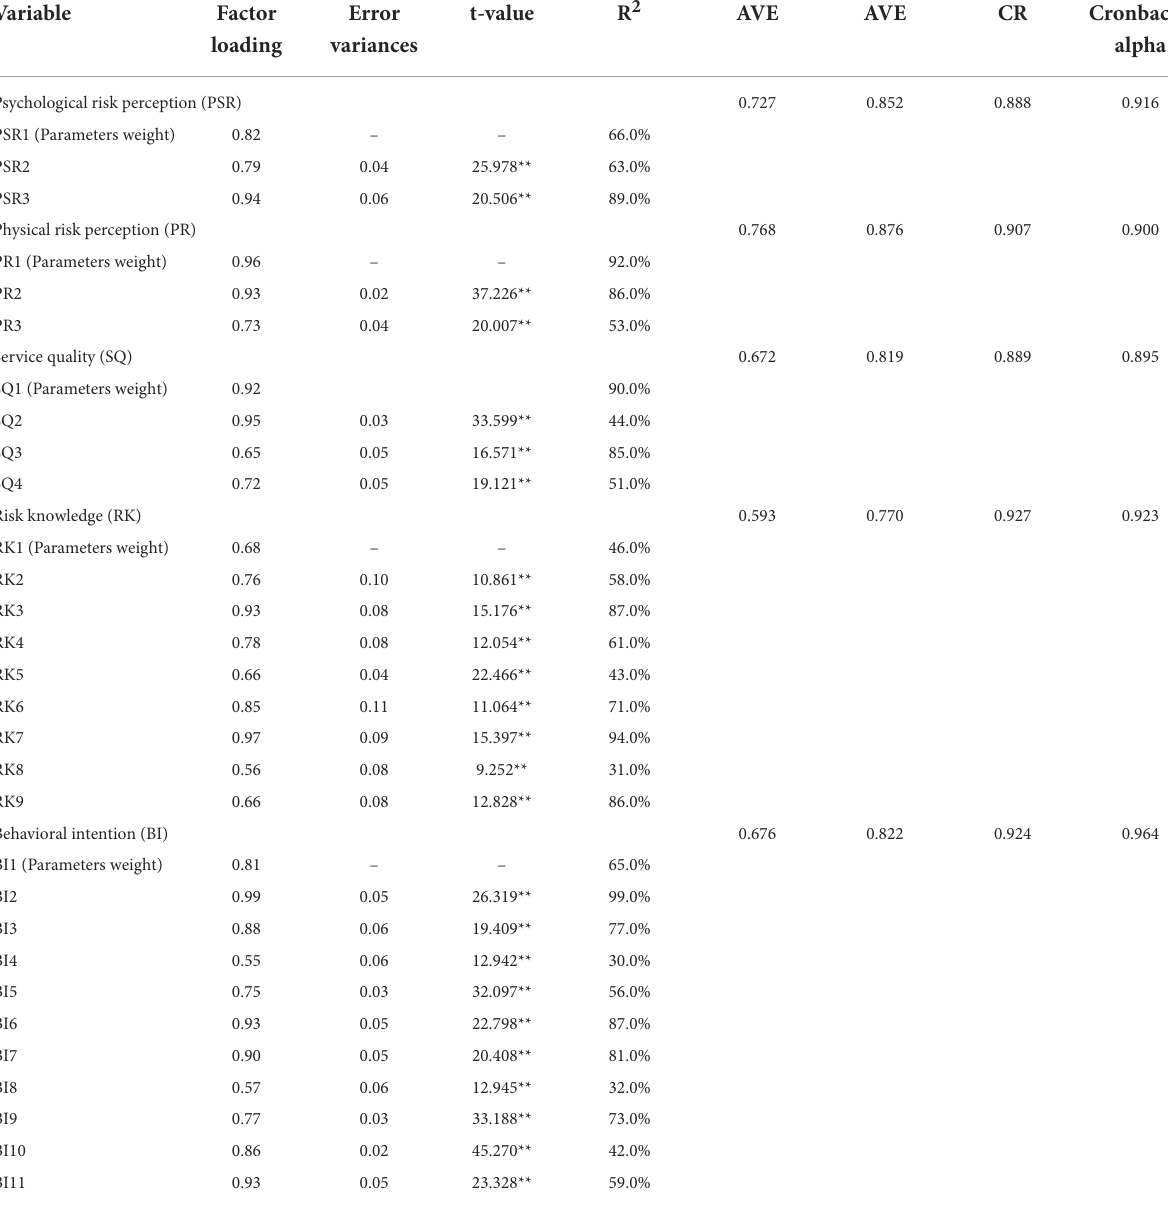
TABLE 3 Analysis statistics of confirmatory factor analysis (CFA) of the model of risk knowledge pathways to behavioral intention of air travel risk perception during COVID-19.